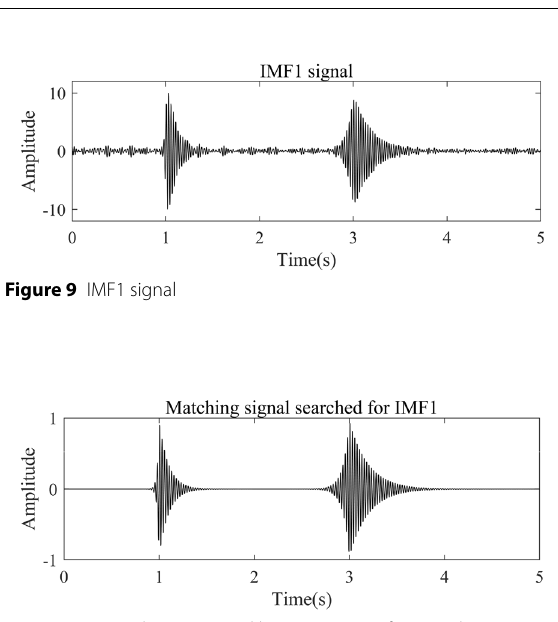
Figure 10 Signals constructed by parameters after searching